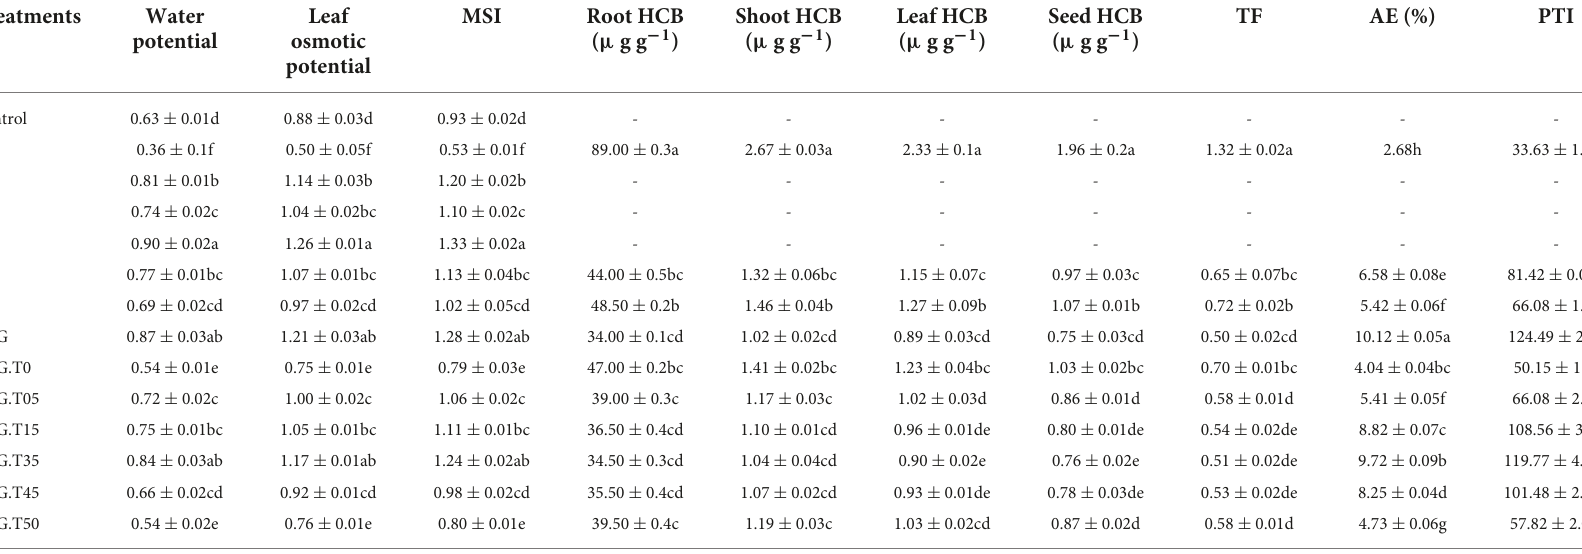
TABLE 3 Effect of GA 3 and BioClay nanosheets on water potential, leaf osmotic potential, membrane stability index (MSI), root, shoot, leaf and seed HCB uptake, translocation factor (TF), avoidance efficacy (AE) and pollutant tolerance index (PTI) of Brassica alboglabra under temperature stress, and hexachlorobenzebe (HCB) toxicity.